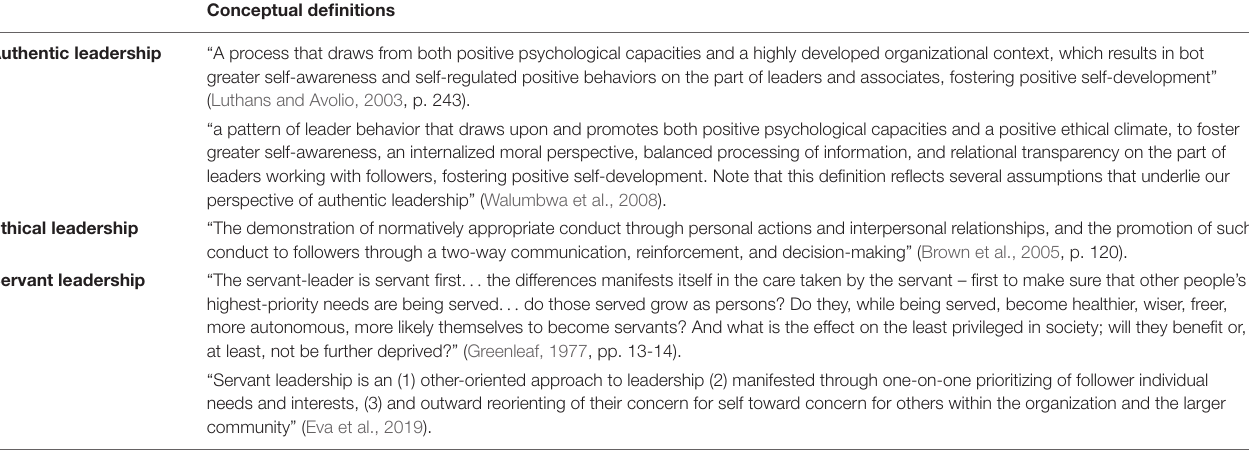
TABLE 1 | The conceptual definitions of value-based